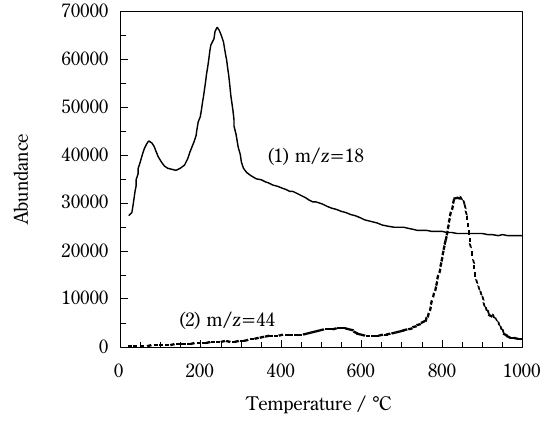
Fig. 10 TG-MS measurement of BaTiO 3 prepared by sol-gel method (Flow rate (cid:3) 1.24 m/s).